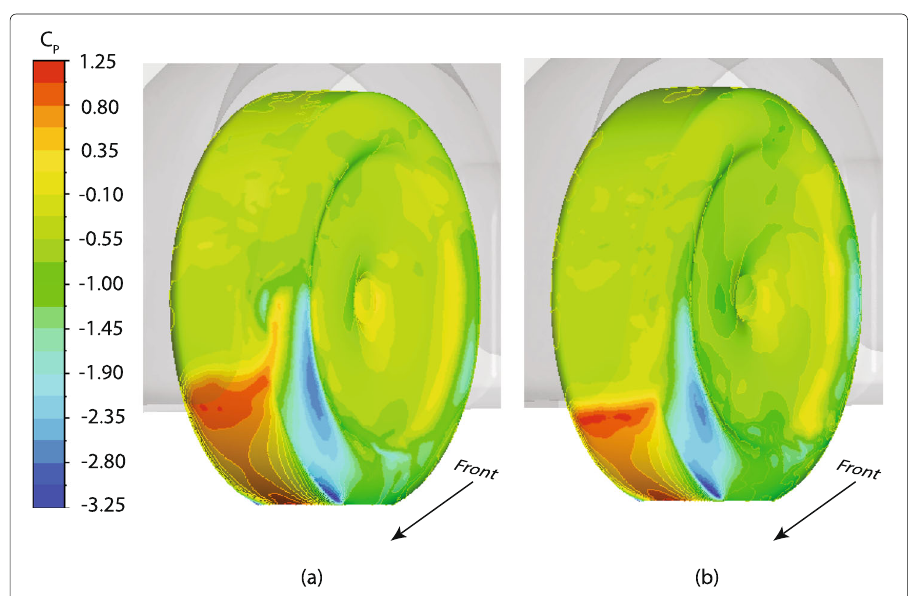
Fig. 11 Pressure coefficient contours on the front left wheel for U ∞ = 45 m/s (a) baseline and (b) 15-mm conventional wheel deflector